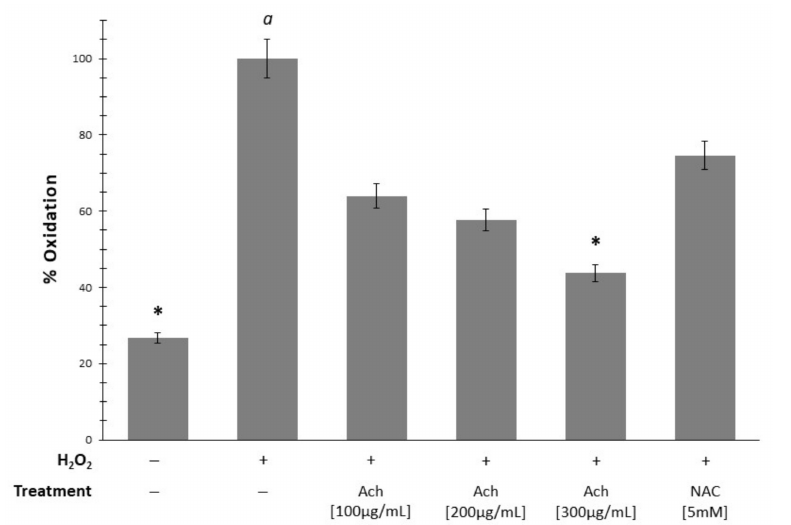
Figure 5. Supplementation with Ach to HT-29 cells stressed with 0.05% H 2 O 2 decreases oxidation status in a dose-dependent manner, and more efficiently than NAC. Data are expressed as the mean ± SEM and the measured percent oxidation were expressed as a percentage from the positive control (cells induced by H 2 O 2 ). *A p -value < 0.05 indicates significant differences with respect to a . Positive sign (+): presence of treatment; negative sign ( − ): absence of